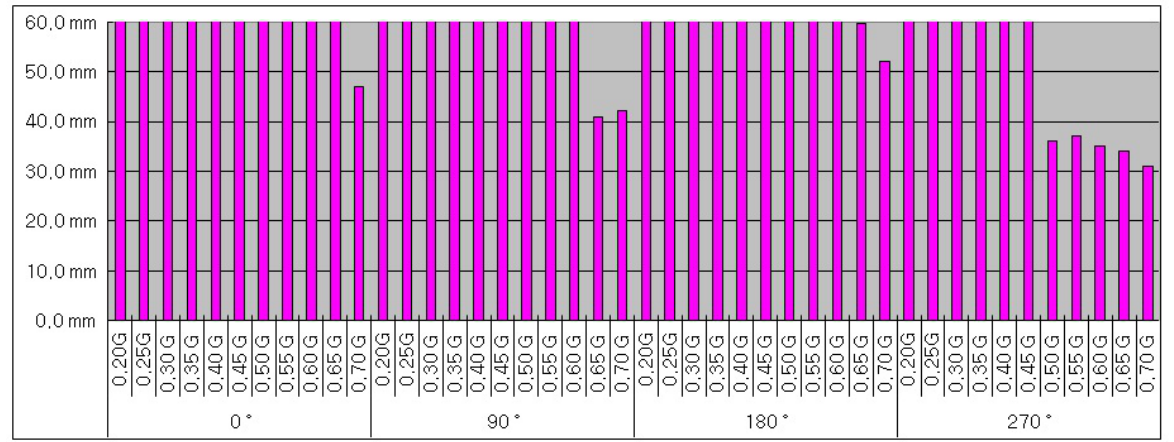
Figure 13. Measured extension of webbing vs.